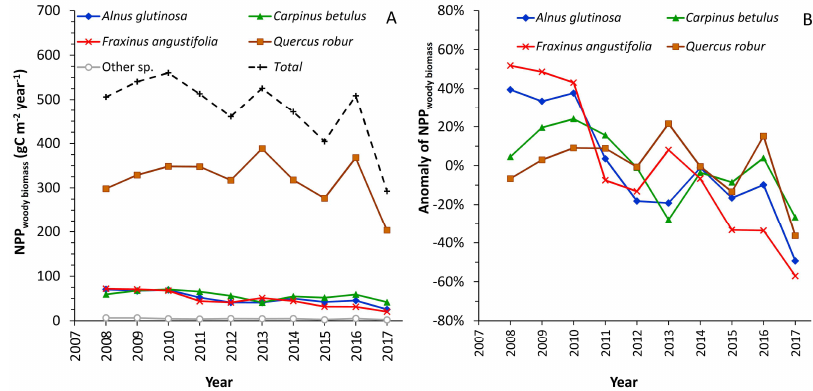
Figure 10. NPP WBt of total woody biomass (above- and below-ground) according to tree species ( A ); anomaly (relative deviation from the mean) of NPP WBt for the main tree species during the period 2008–2017 ( B